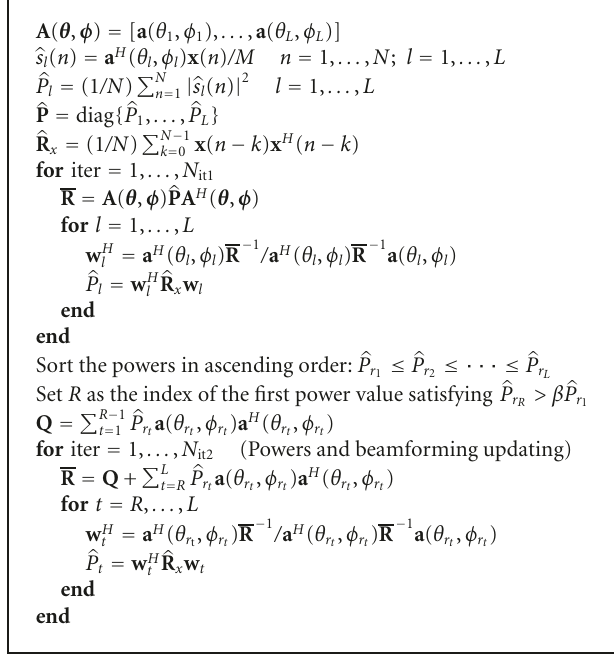
Algorithm 3: IAA-RC